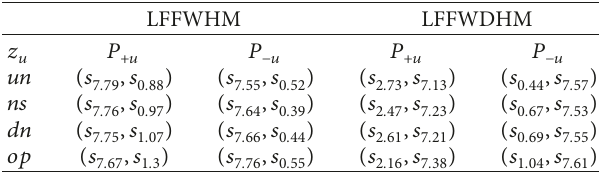
Table 6: Maximizing and minimizing index values.